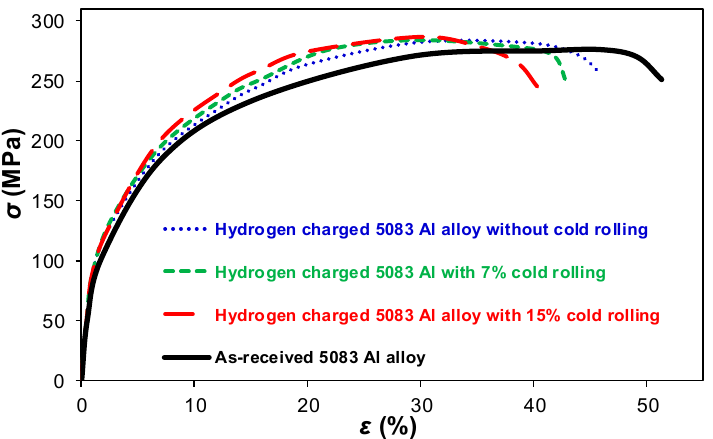
Figure 4. Stress-strain curves for the as-received 5083 aluminum alloy and the hydrogen charged alloy without cold rolling, with 7% cold rolling and with 15% cold rolling, charged at 30 mA/cm 2 for 6 h.